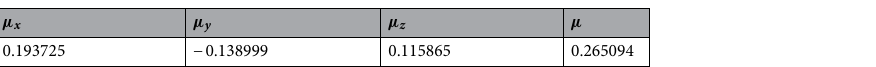
Table 4. Static dipole moment of Lycopene calculated using DFT at B3LYP/6-311 level of theory(in a.u. unit).